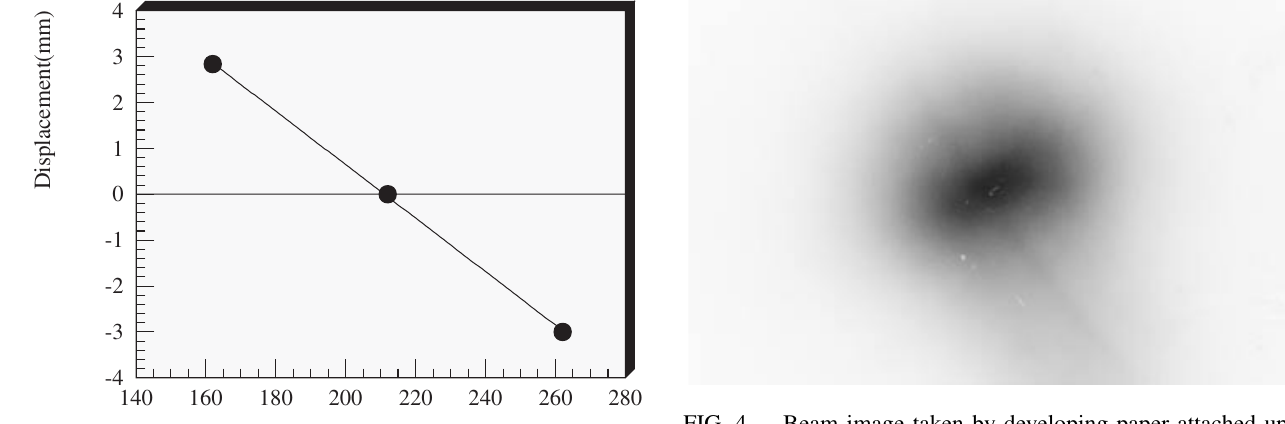
FIG. 4. Beam image taken by developing paper attached up- stream of the test target. The tail, which is extended to the lower right direction, is considered to be made by lower energy particles, which scatter with the vacuum window and the air